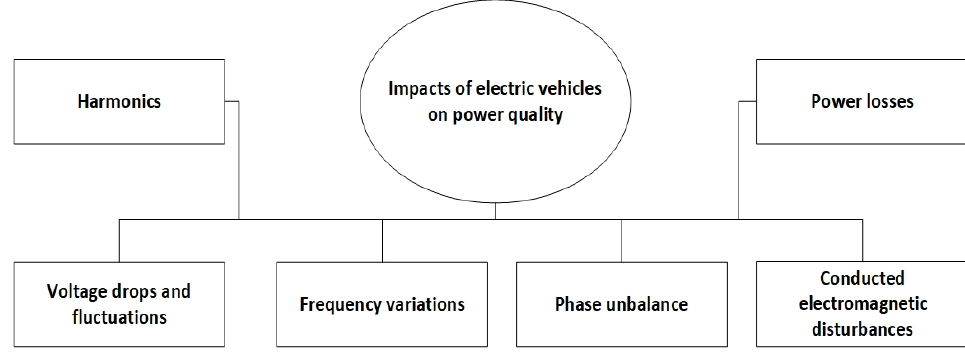
Figure 1. Impacts of EVs on power quality.